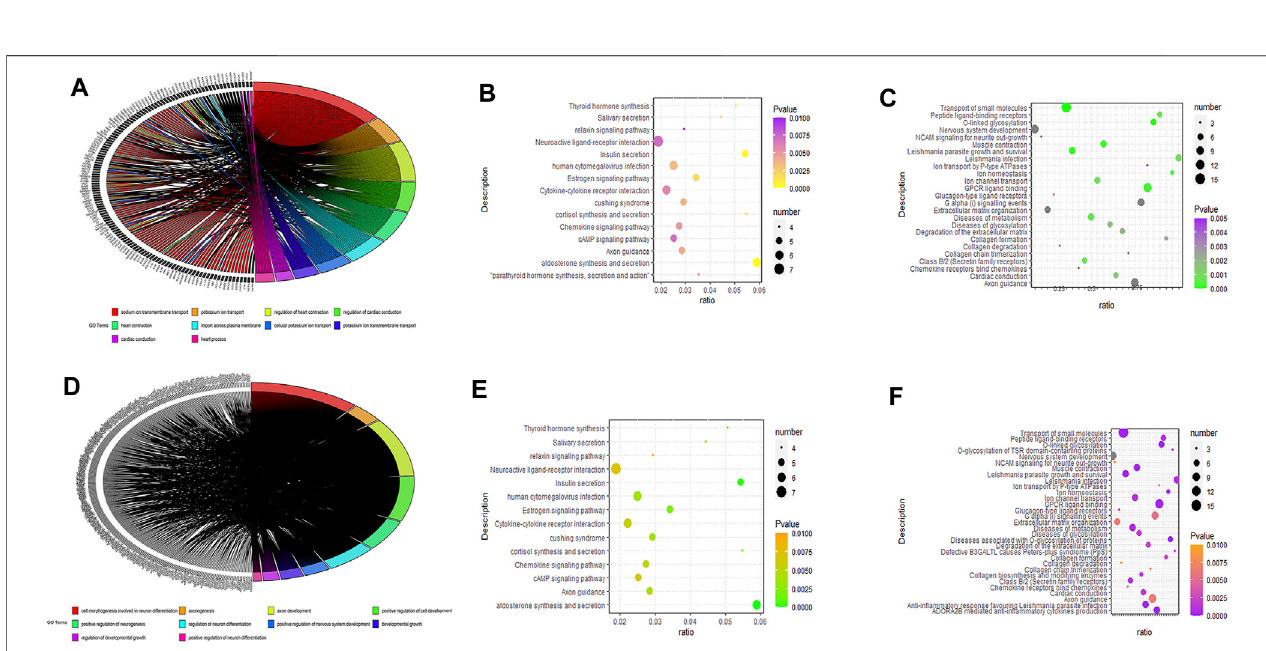
FIGURE 3 | Gene ontology (GO)/Kyoto Encyclopedia of Genes and Genomes (KEGG) pathway enrichment analysis and visualization of messenger RNAs after intersection of micro RNA target genes. Visualization of GO pathway enrichment analysis results for differential target predicted crossover genes ( Figures 3A, D ); visualizationofKEGGpathway enrichmentresults ( Figures3B,E );visualizationofREACTOME pathway enrichment results( Figures3C,F );differential targetpredicted crossover genes with logFC > − 1.5 ( Figures 3A – C ); differential genes with logFC < − 1.5 ( Figures 3D – F ).